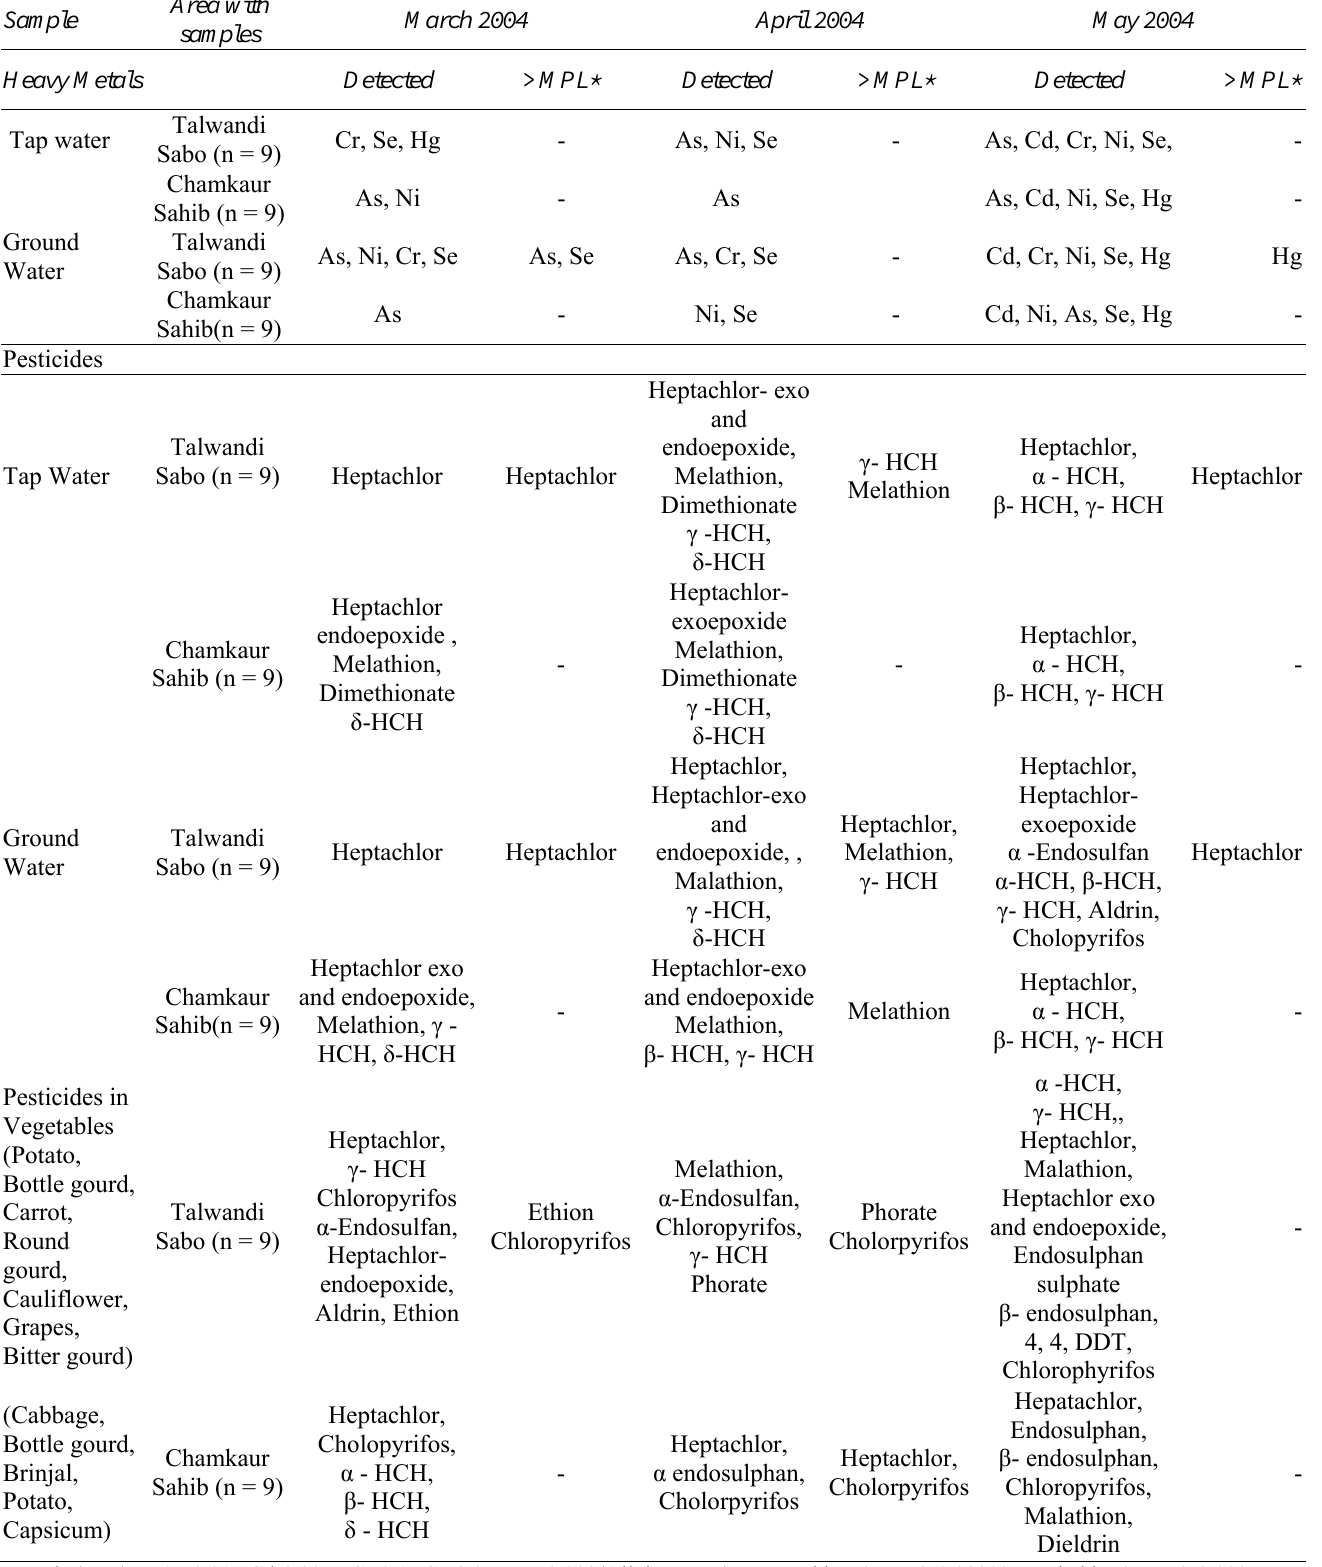
Table 5 : Area-wise Pesticides and Heavy metals in drinking water and vegetables in Talwandi Sabo and Chamkaur Sahib